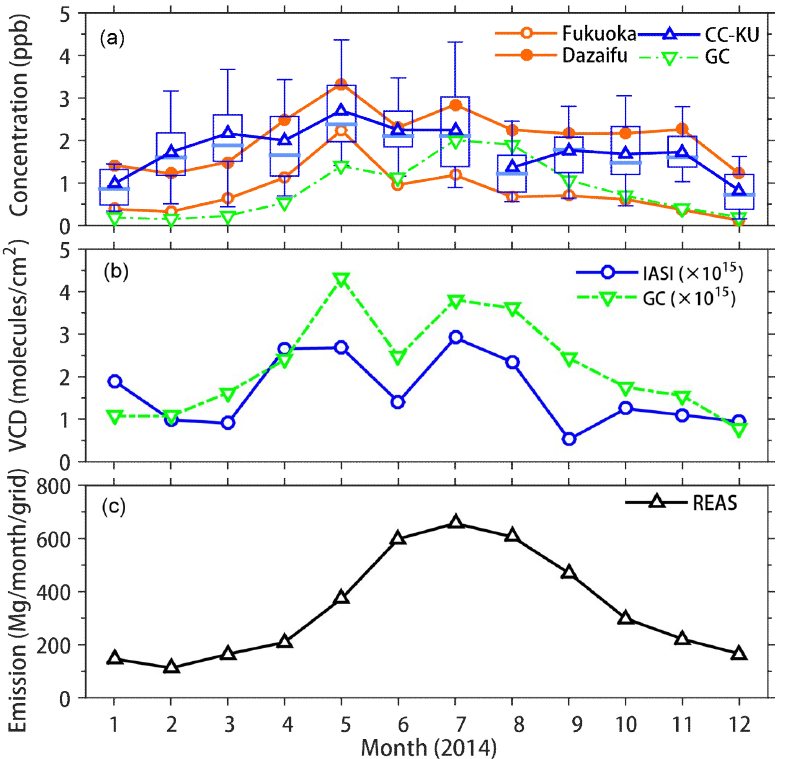
Figure 9. Time series of NH 3 in the Kyushu area ( a ) FP and GEOS-chem concentrations in Fukuoka, Dazaifu and CC-KU (box-whisker), ( b ) IASI and GEOS-Chem VCDs, and ( c ) REAS NH 3 emissions.